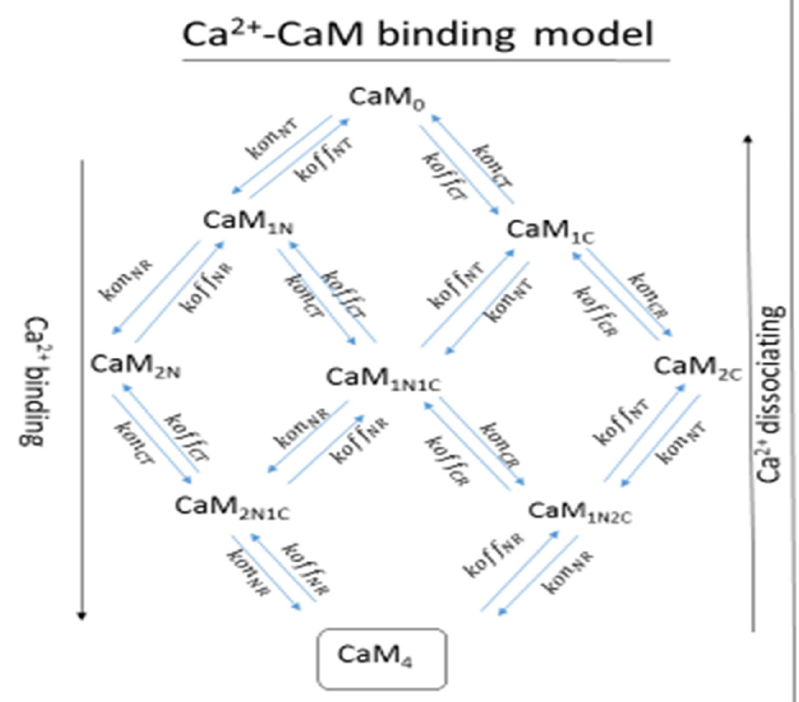
Figure 2. A schematic diagram of the reactions of the model used. On the left is the Ca 2+ -CaM binding model. Here, CaM o represents CaM bound to no Ca 2+ ; CaM 1N/2N/1C/2C represent 1 and 2 Ca 2+ ions bound to the N ‐ or C ‐ lobe, while CaM 4 , the output of the model, represents Ca 2+ binding and dissociation, respectively, with the subscripts after representing either the T or R state in which the Ca 2+ is binding or unbinding.. Table 3. Parameters used and values used in the full CaM model. All values used are from [48].